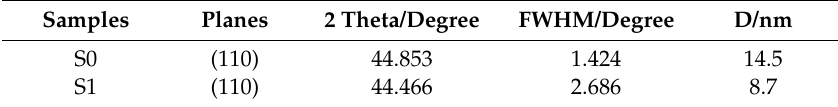
Table 3. The calculation results of grazing incidence X-ray diffraction (GIXRD) Table 3 The calculation results of grazing incidence X-ray diffraction (GIXRD) spectra.